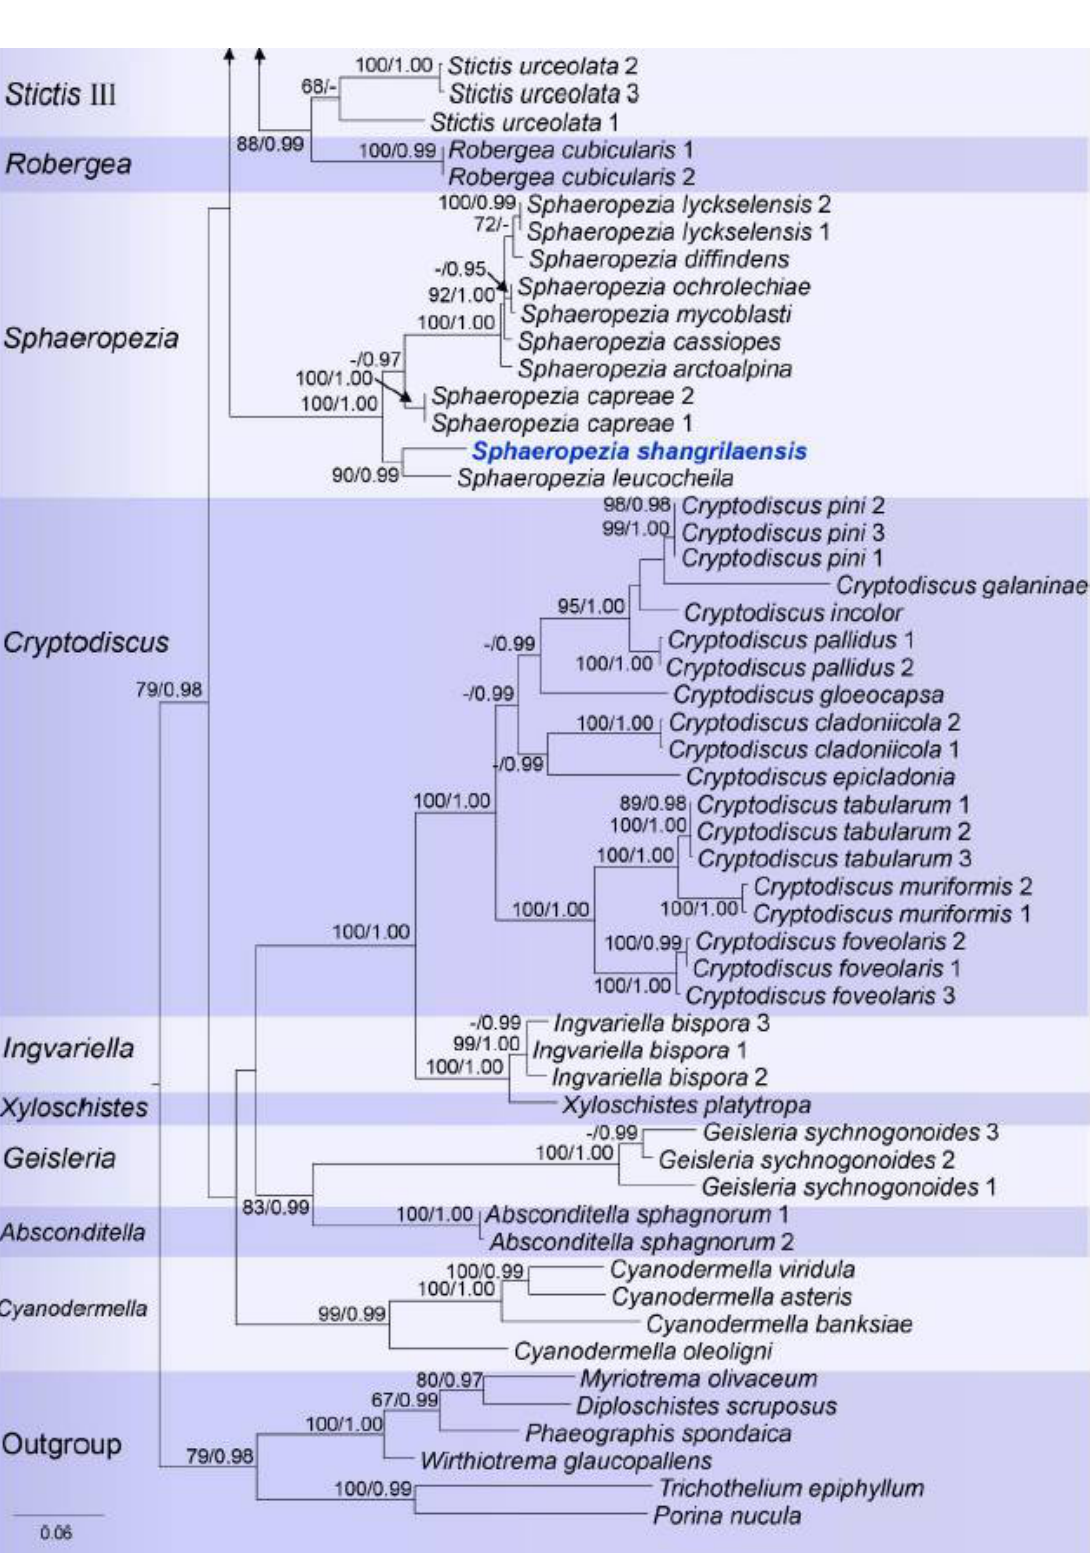
Figure 2. RAxML tree based on analysis of combined mtSSU, LSU, and ITS partial sequence data for Stictidaceae. Bootstrap support values for Maximum Likelihood (ML) equal to or greater than 65%, and Bayesian posterior probabilities (BP) equal to or greater than 0.90 are given as ML/BP above the nodes. The new species and the genus found in this study are displayed in blue